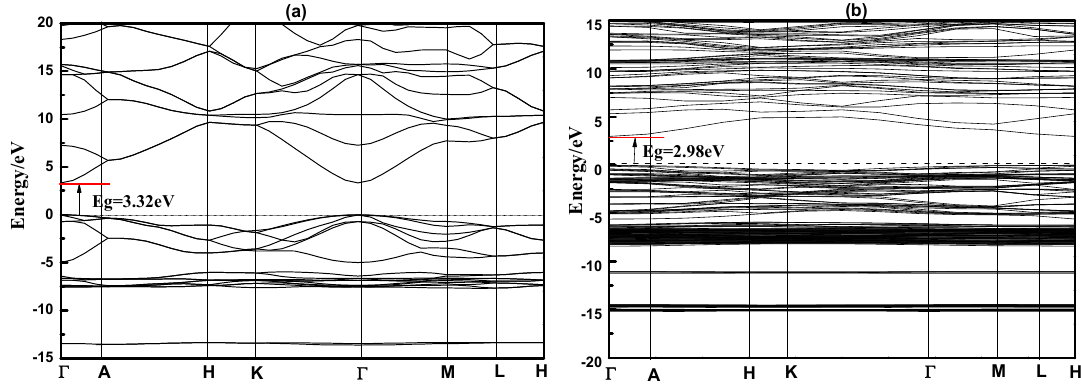
Figure 3. Calculated band structures of ( a ) pure ZnO and ( b ) ZnO:In.